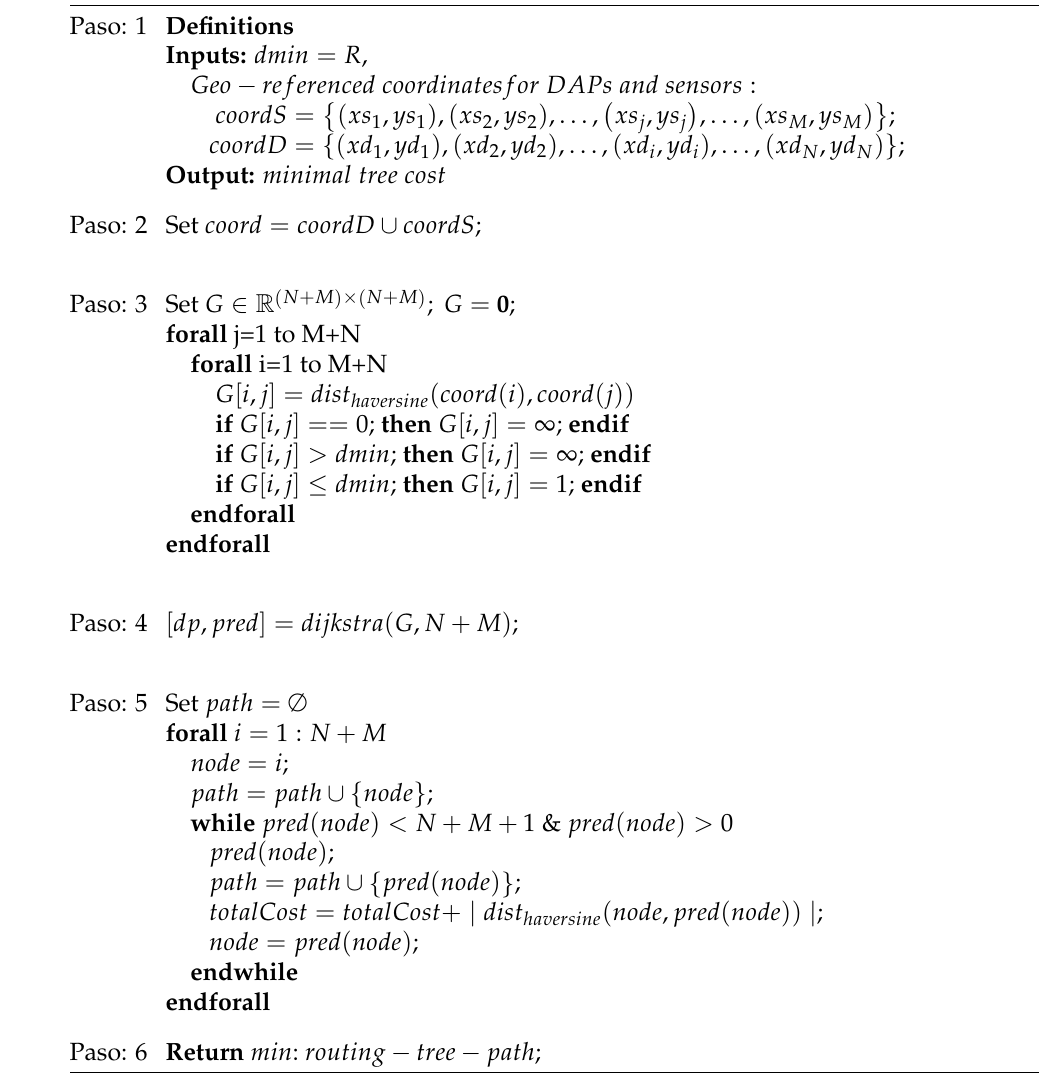
Algorithm 2 ORWSN : Routing of Wireless Sensor